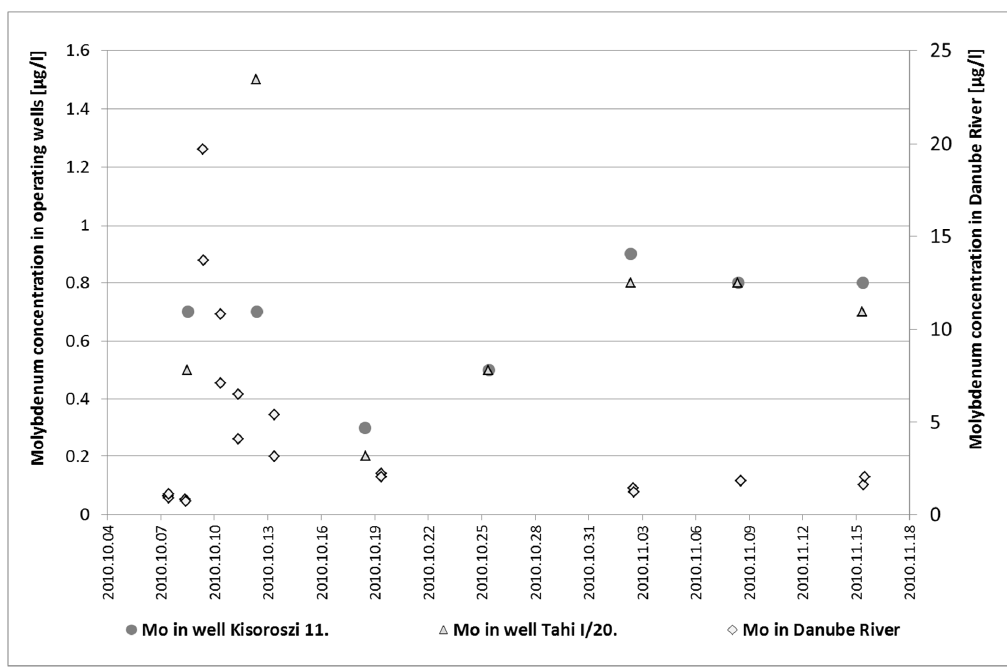
Figure 4. Molybdenum concentrations in Danube River water and bank filtrate in production wells during the red mud spill in October 2010. Lower LOD is 1 µg/l for molybdenum.